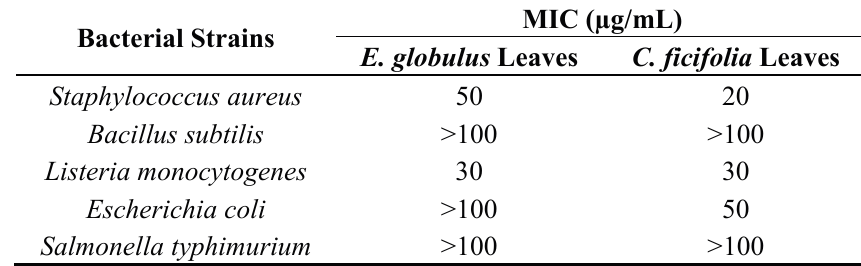
Table 5. Minimal Inhibitory Concentration (MIC) of E. globulus and C. ficifolia extracts. Bacterial